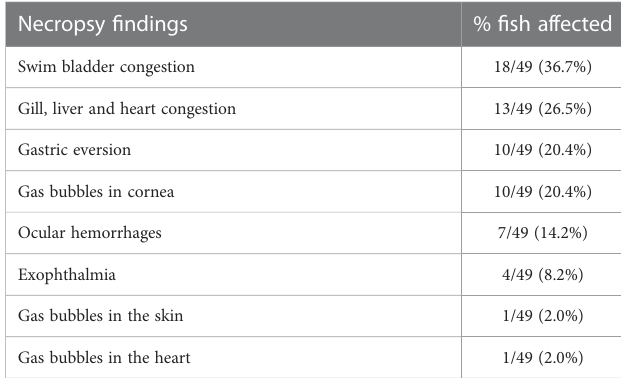
TABLE 1 Necropsy fi ndings reported in dead fi shes from El Hierro volcano eruption. Necropsy fi